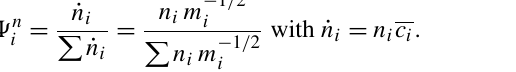
gen generated in the discharge is expanded into the vacuum through a small orifice (6) ( ∅ 0.3 mm) along with undissoci- ated O 2 and forms a fast molecular beam with a distinct ra- dial and axial distribution of the atomic oxygen density. This radial beam profile can be probed by a FIPEX sensor (10) mounted on a linear manipulator (11) (MDC Vacuum Prod- ucts) and, exploiting the radial symmetry of the beam, by a quadrupole mass spectrometer (9) (QMS; Hiden HAL 3F) on a movable flexible bellow (12) from the opposite